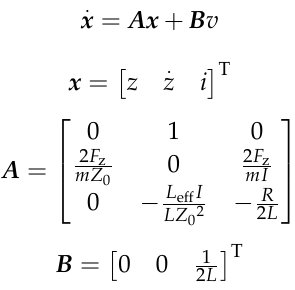
Figure 6. Relationship between the gap and current. Flexible steel plates levitate by following this relationship in the proposed system.